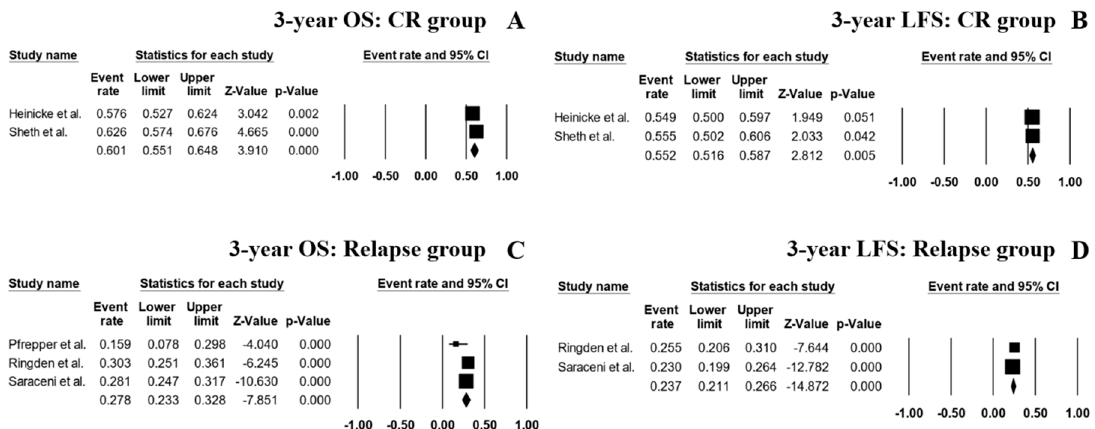
Figure 5. Forest plots of pooled estimates (95% CI) for outcomes of the patient’s subgroups; ( A ): 3-year OS of CR1 or CR2 patients; ( B ): 3-year LFS of CR1 or CR2 patients; ( C ): 3-year OS of acute myeloid leukemia (AML) patients with relapse and / or refractory disease; ( D ): 3-year LFS of high risk AML patients with relapse and / or refractory disease.